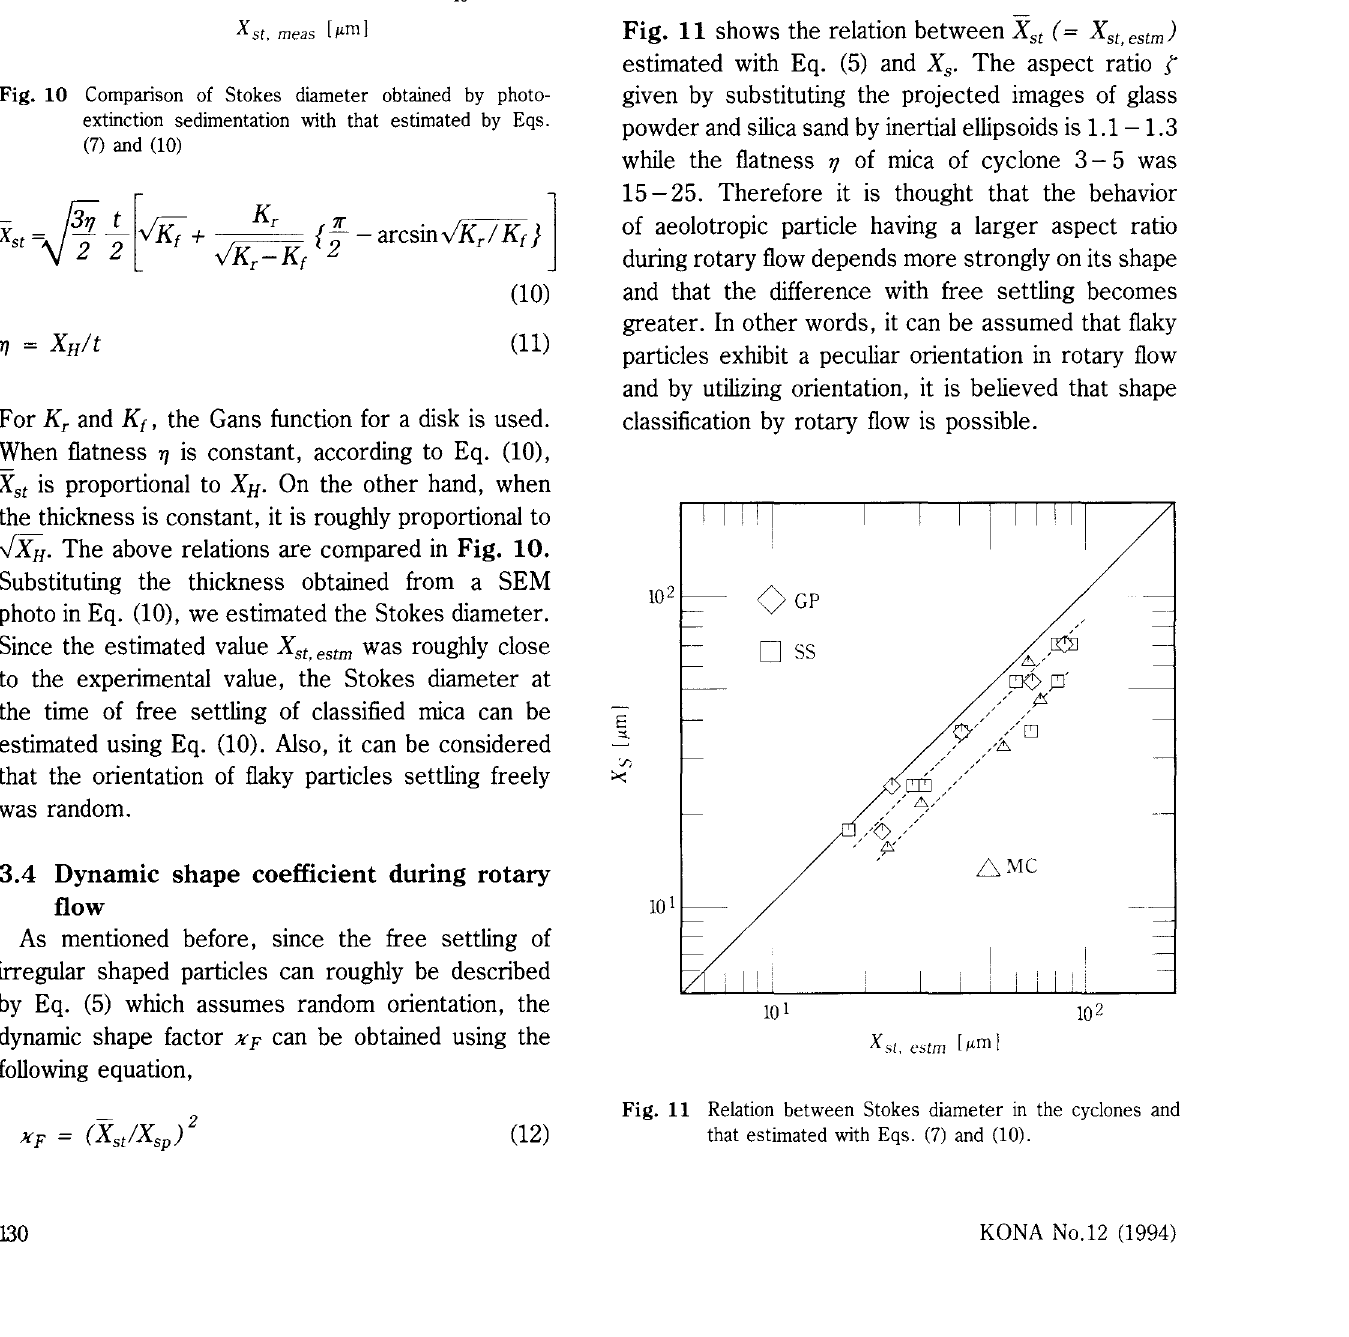
Fig. 11 Relation between Stokes diameter in the cyclones and that estimated with Eqs. (7) and